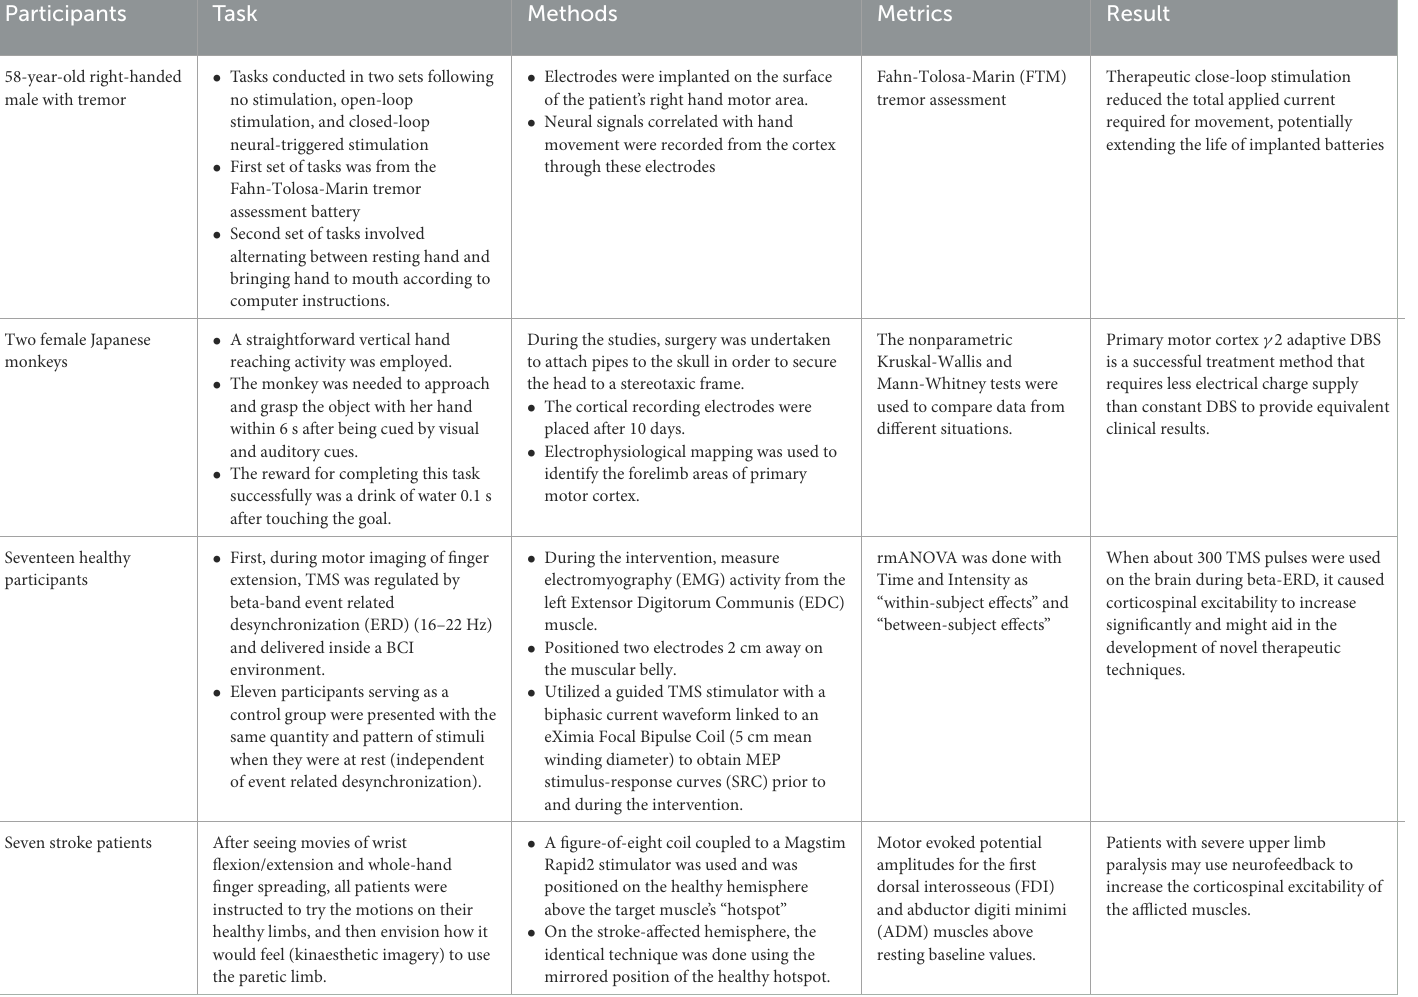
TABLE 3 Potential articles sorted by brain stimulation. Brain stimulation